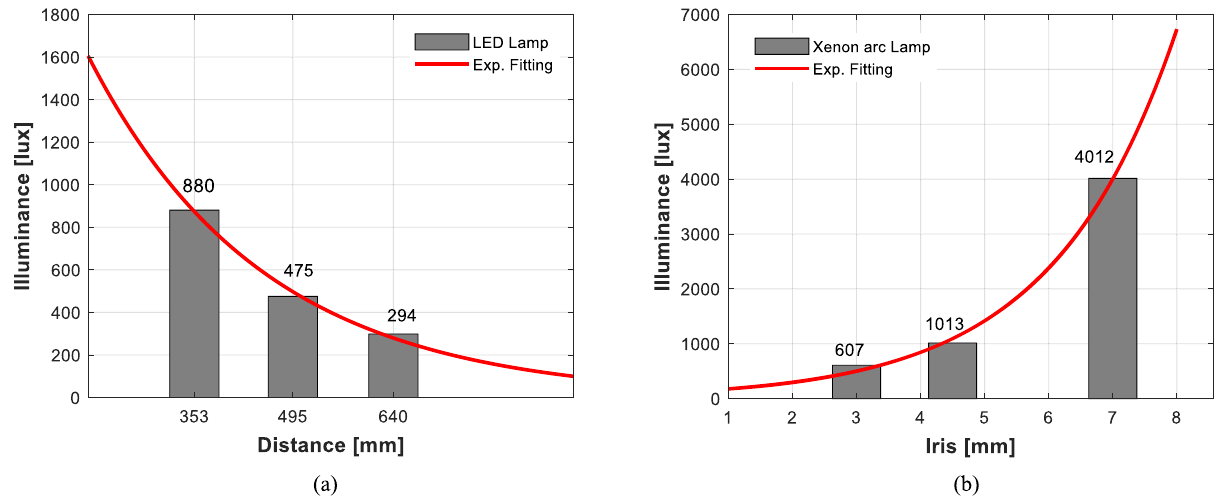
Fig. 4. Illuminance reference mean values, measured by the digital luxmeter, for each of the two light source assemblies: LED Lamp, in (a), and Xenon arc lamp, in (b).